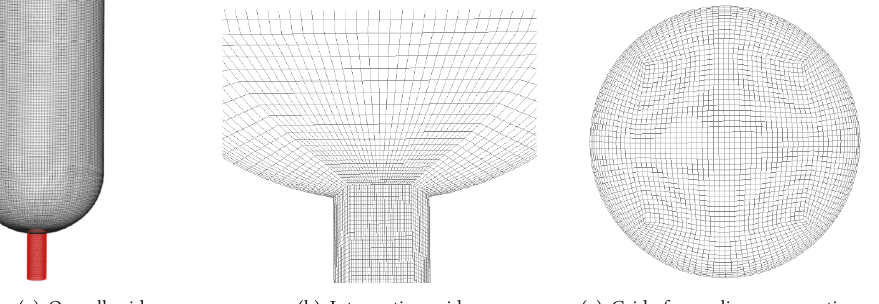
Figure 3: Test section.